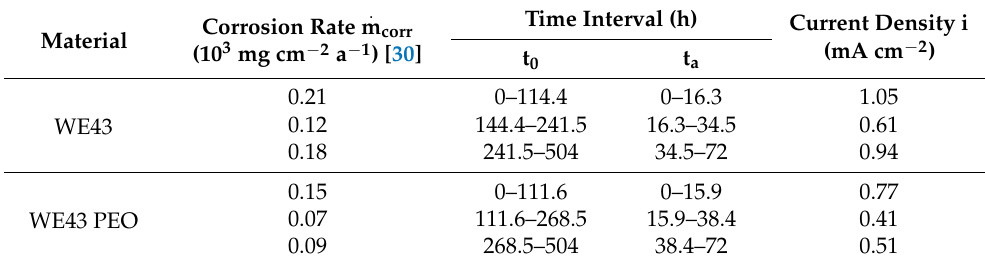
Figure 4. Microstructure of the plasma electrolytic oxidation (PEO) layer: ( a ) SEM image of top view; ( b ) SEM image of cross-section with marked cracks (1), arbitrarily formed (2), and circular pores (3). Investigations performed with a scanning electron microscope (SEM, Mira 3 XMU, Tescan GmbH, Dortmund, Germany). Table 1. Data for the design of immersion tests with galvanostatic polarization on WE43 and WE43 PEO in 0.9% NaCl solution at 36.5 ◦